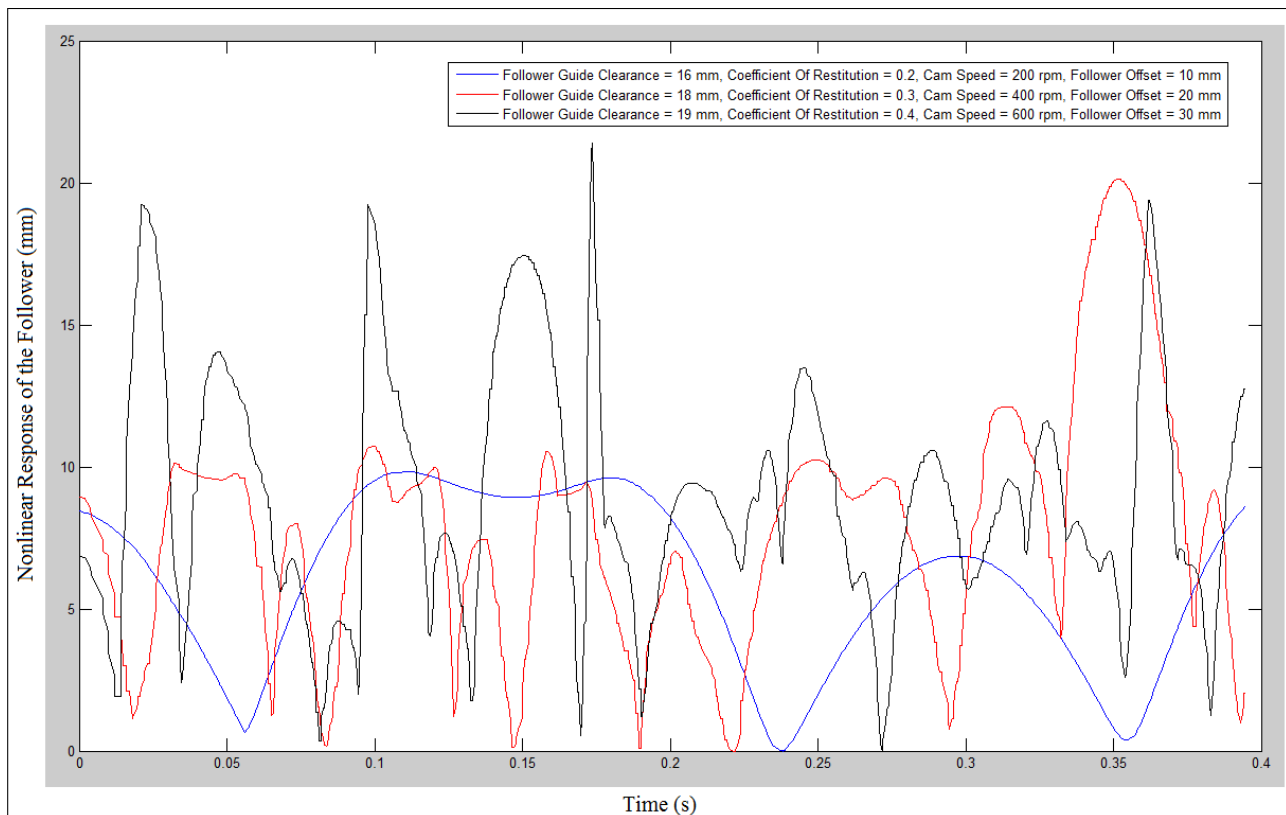
Figure 19. Nonlinear response when the follower offsets to the right (O = 10, 20, and 30 mm) at different cam speeds, different follower guide’s clearance and different coefficients of restitution.